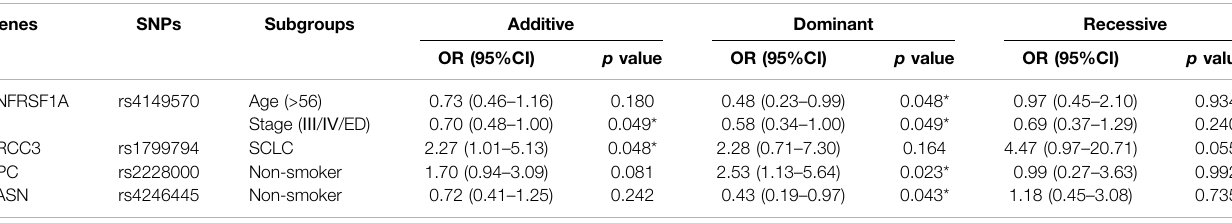
Additive model: comparison between minor allele subjects and major allele subjects. Dominant model: comparison between minor allele carriers and major homozygous subjects. Recessivemodel:comparisonbetweenmajorallelecarriersandminorhomozygoussubjects.OR,oddsratio;CI,con fi denceinterval; p , p -valueforbinarylogisticregressionanalysis;Ref., reference. * p <